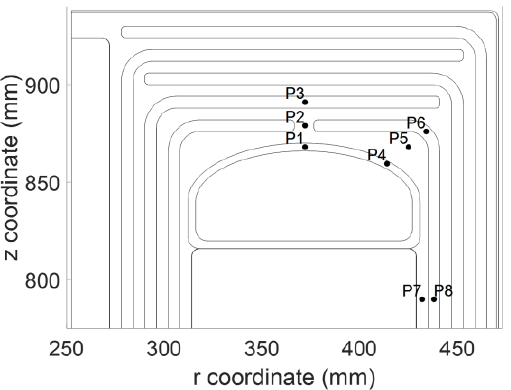
Figure 9. The position of some typical points in the dielectric structure of the MFT to investigate their stresses in time domain.